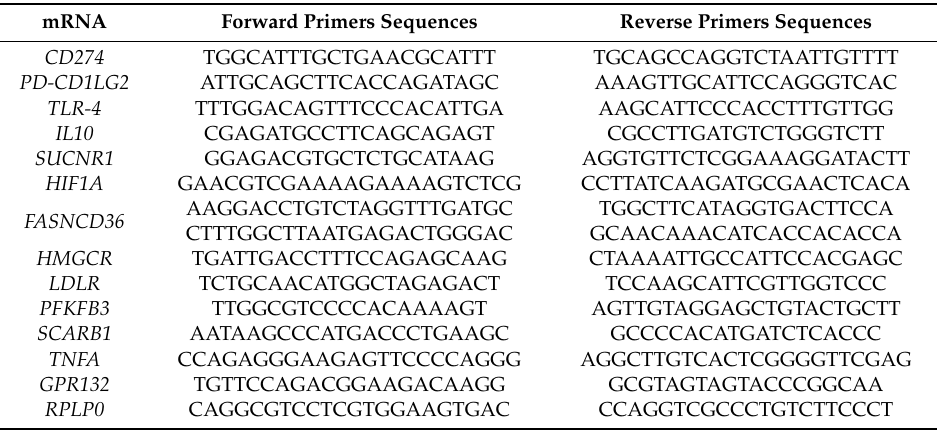
Table 2. mRNA primer sequences (human sequences; 5 (cid:48) –3 (cid:48)